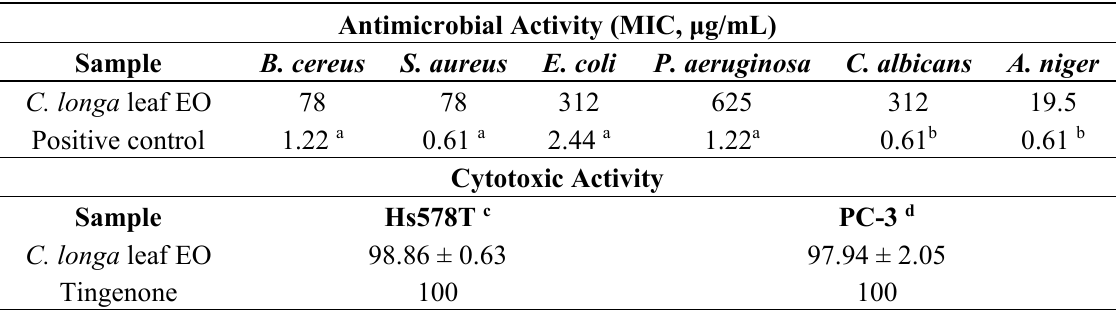
Table 2. Biological activities of Curcuma longa leaf essential